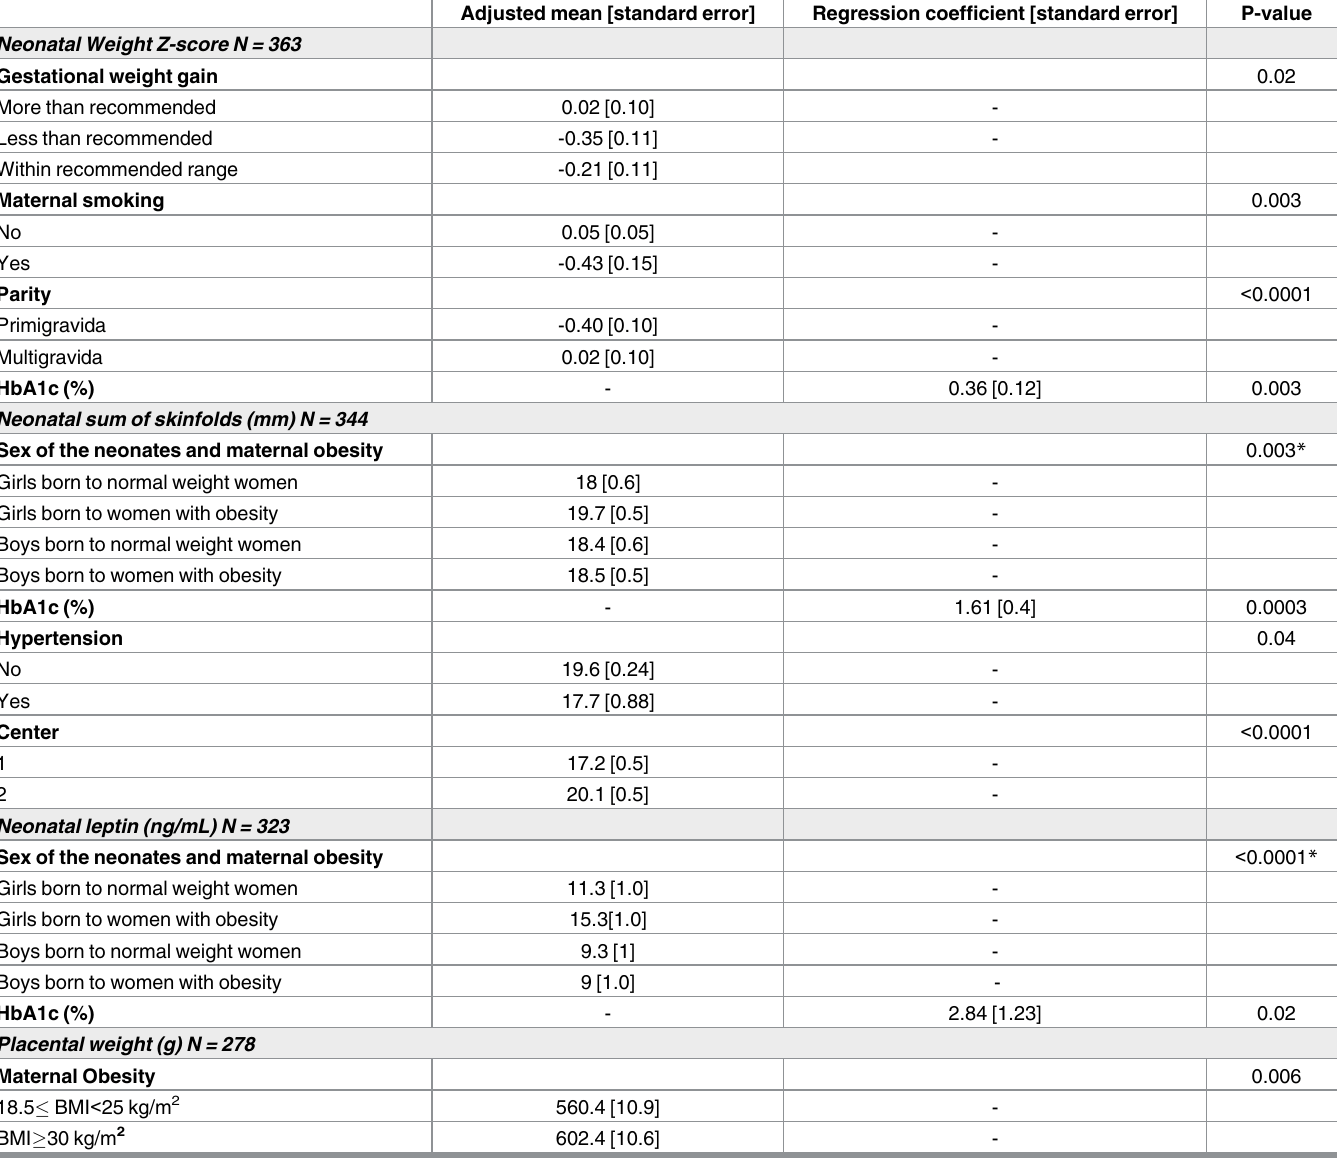
Table 3. Factors associated with neonatal weight Z-score, sum of skinfolds, leptin and placenta weight in multivariate analysis. Data are presented with adjusted mean [standarderror] for categorical variablesor regression coefficient [standarderror] for continuous variables. Adjusted mean [standard error] Regression coefficient [standard error] P-value Neonatal Weight Z-score N =